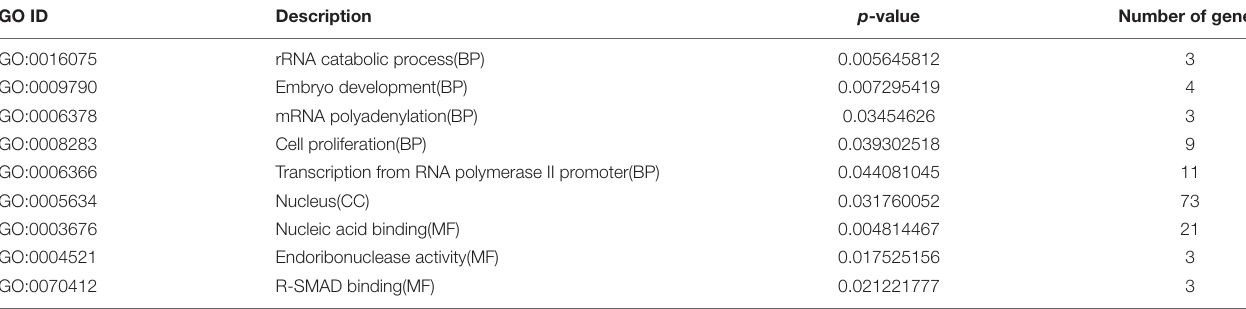
TABLE 1 | GO terms associated with FAM83 family members and their 259 co-expression genes in STAD patients ( P < 0.05).